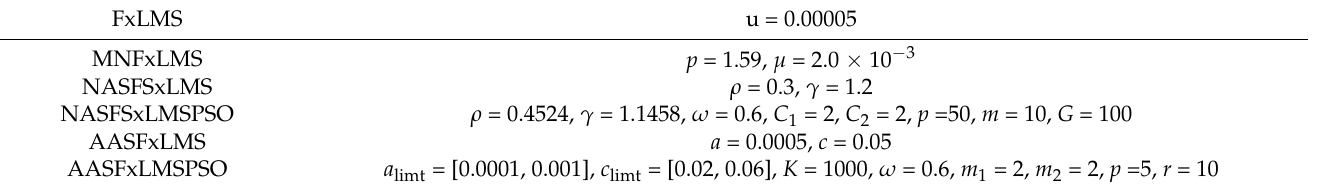
Table 2. The key parameters of each algorithm in the MATLAB simulation of Example 2.